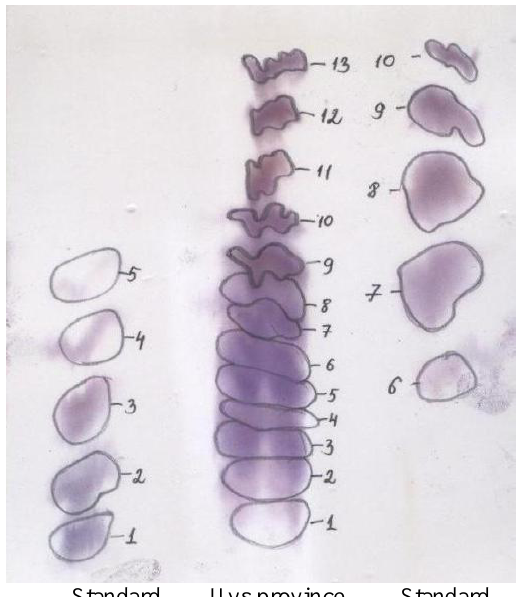
Fig. 1. Chromatogram of experimental and standard amino acids.